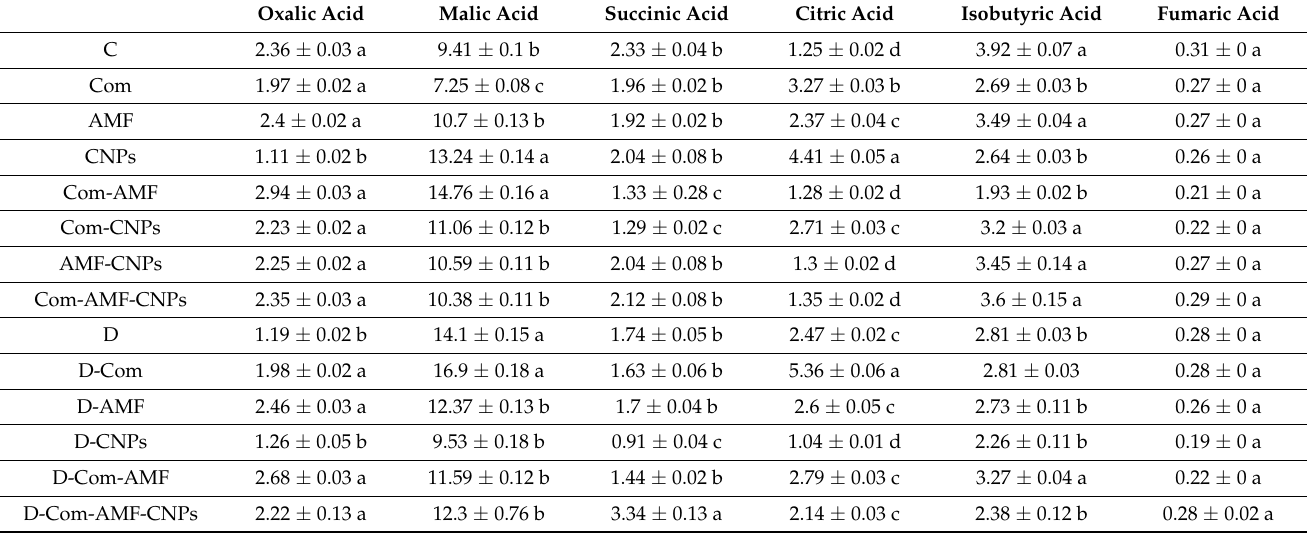
Table 2. Effect of different treatments on organic acids (mg g − 1 DW) of maize under control and drought (D) conditions. Different letters indicate statistically significant difference between means for the different treatments at significance level of at least p ≤